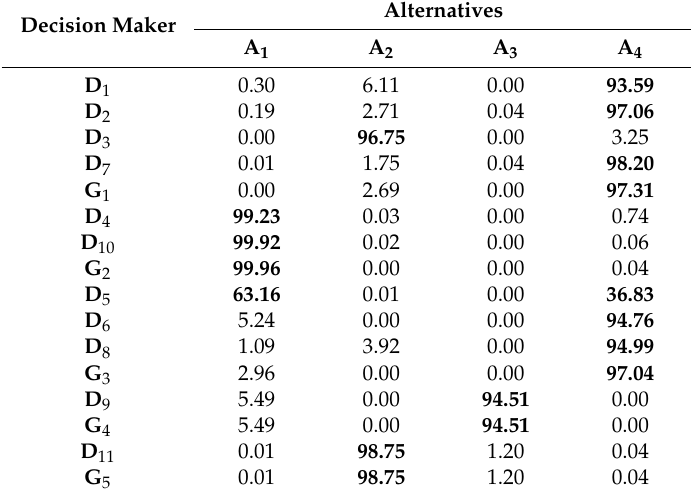
Table 2. Alpha distributions for each decision maker and each